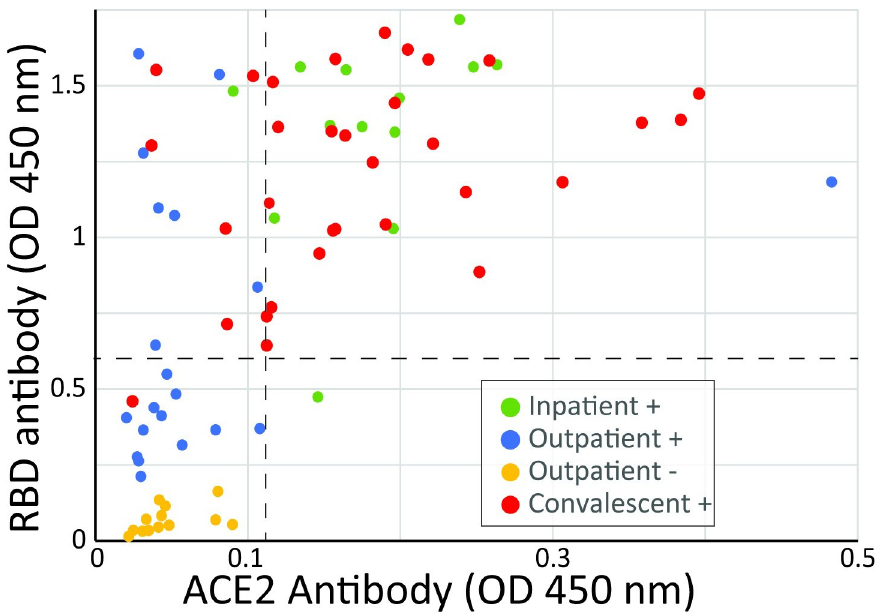
Fig 1. Abundance of antibodies that recognize the SARS-CoV-2 RBD and ACE2 protein in plasma or serum. The dotted line represents the cut-off values for a positive antibody test that was defined as the value of the mean of negative controls plus 3 standard deviations.